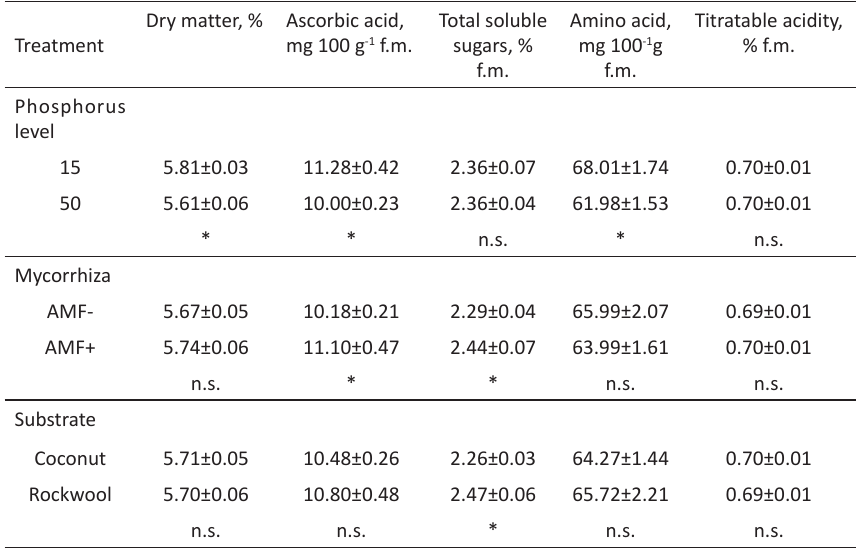
Table 3. The effect of phosphorus level in nutrient solution (mg dm -3 ), mycorrhiza and type of substrate on quality of tomato